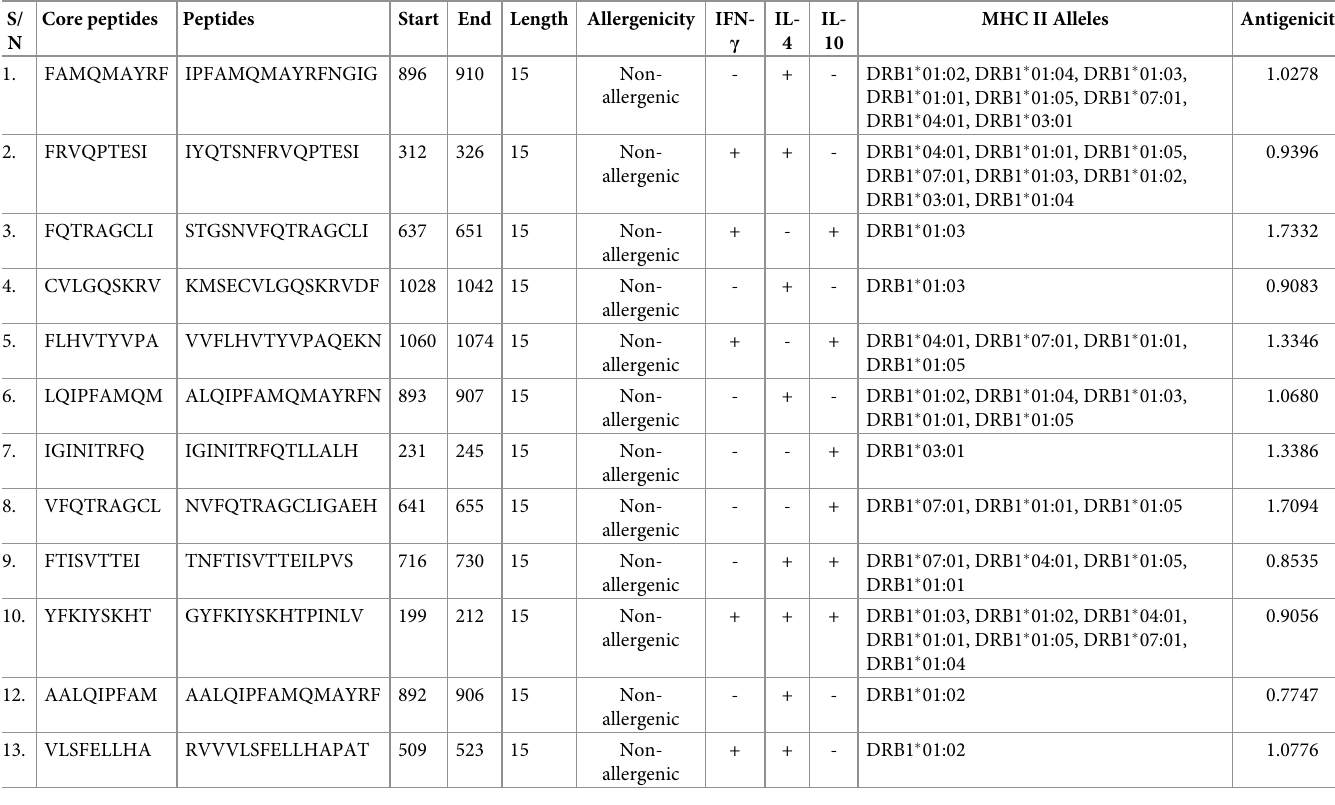
Table 4. MHC class II T-cell epitopes of SARS-CoV-2 spike glycoprotein. S/ Core peptides N